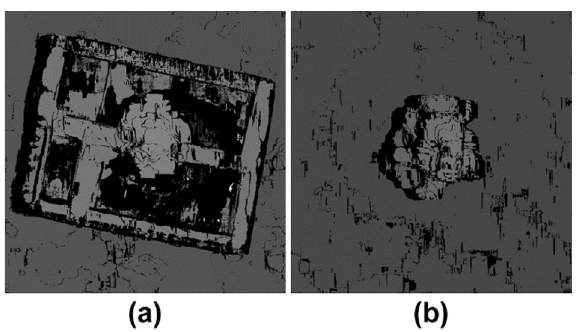
Figure 9. Two enlarged parts of the disparity map shown in Fig. 8. ( a ) Plant in the carboard box and ( b ) plan on the ground.